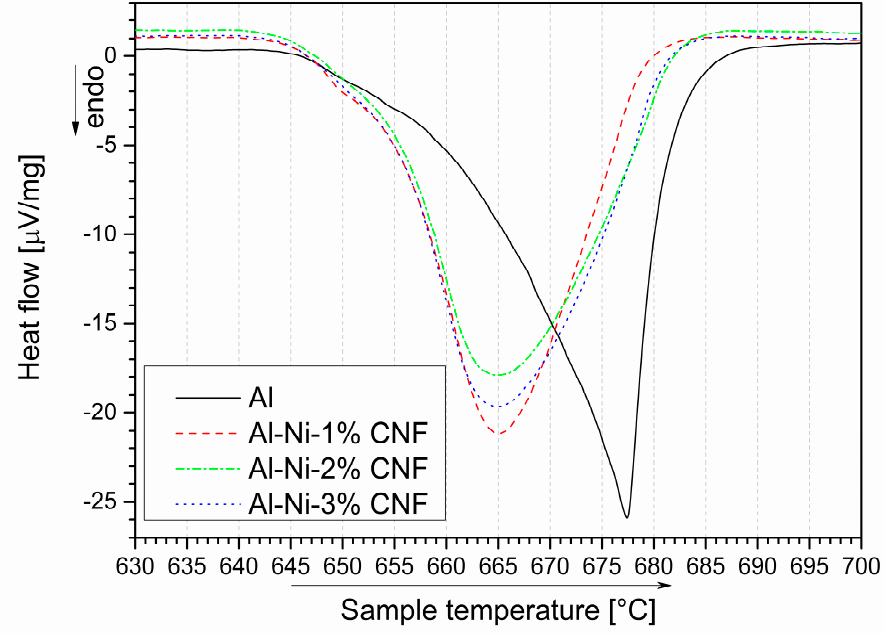
Figure 4. DSC curves of aluminum with various CNF content during heating near Al melting point.